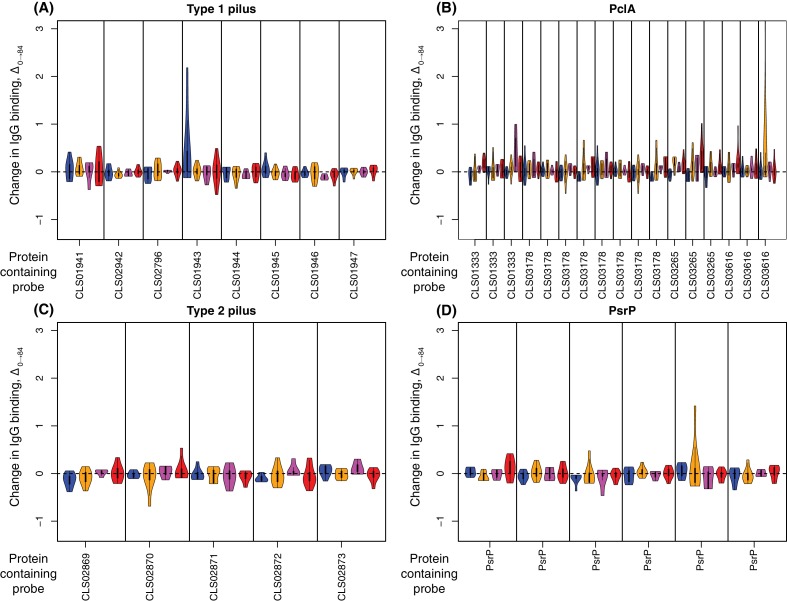
Change in IgG binding to large antigenic structures.Data are shown as in Figure 4—figure supplement 8. The type one and two pili, and the pneumococcal serine-rich repeat protein (PsrP), are all absent from S. pneumoniae RM200, and therefore WCV is not expected to trigger an elevated IgG response to these structures. The PclA variants CLS01333 and CLS03265 show some evidence of increased IgG binding, indicating the S. pneumoniae RM200 PclA protein is being recognised by WCV-induced antibodies.